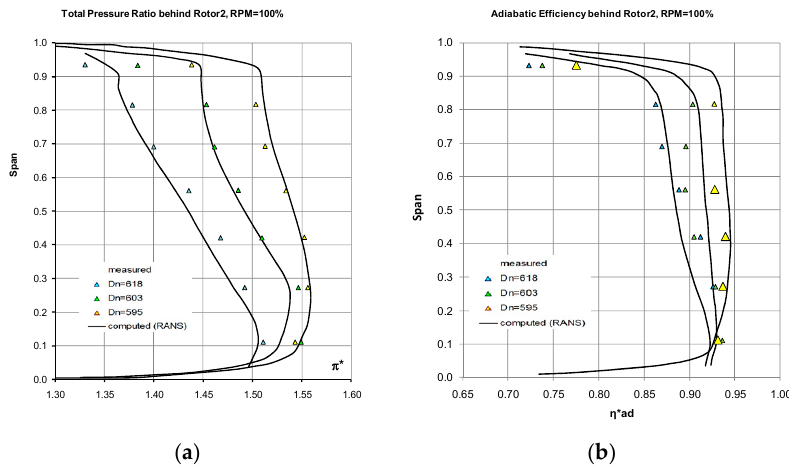
Figure 13. Comparison of computed (3D-RANS, Reynolds Averaged Navier–Stokes) and measured radial distributions of flow parameters downstream from rotor 2, n cor = 100%. ( a ) Total pressure ratio; ( b ) adiabatic efficiency.